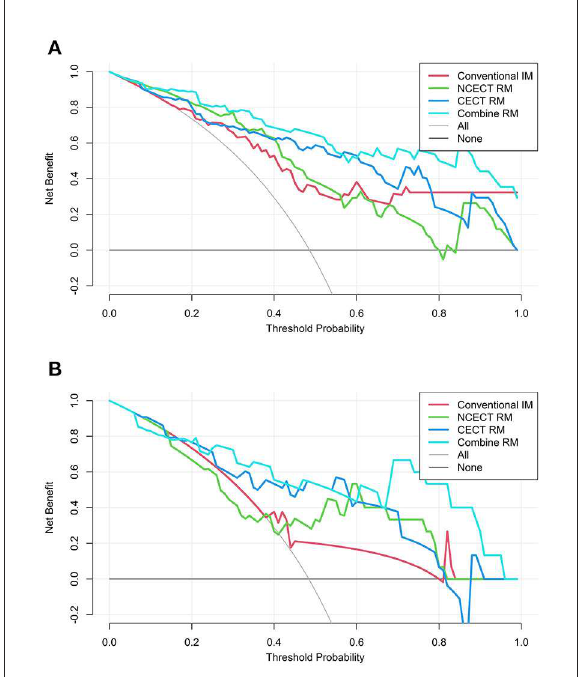
FIGURE5 The decision curves for four models in the training set (A) and the test set (B) . The vertical coordinate represents the net benefit and the horizontal coordinate represents the probability thresholds. None means that all patients were diagnosed with NTIL, no intervention was performed, and the net benefit was 0. All means that all patients were diagnosed with TB, and all patients received intervention, and the net benefit is a backslash with a negative slope. The farther the model curve is from these two extreme curves, the more valuable the model is. TB, tuberculosis; NTIL, non-tuberculous infectious lesions; RM, radiomics